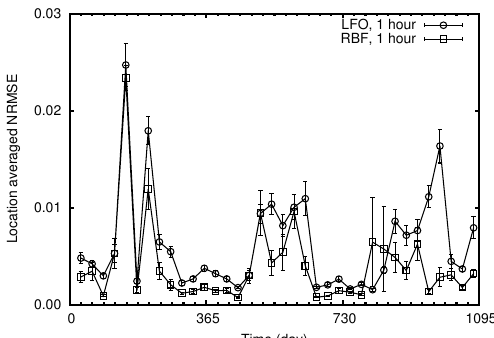
Figure 12. NRMSE, with standard error, of 1h prediction for the Fig. 12. NRMSE, with standard error, of 1 hour prediction for the period of 3 years from 2004 over 234 locations using LFO and RBF. period of 3 years from 2004 over 234 locations using LFO and RBF. The lines connecting the symbols are to guide the eye. The lines connecting the symbols are to guide the